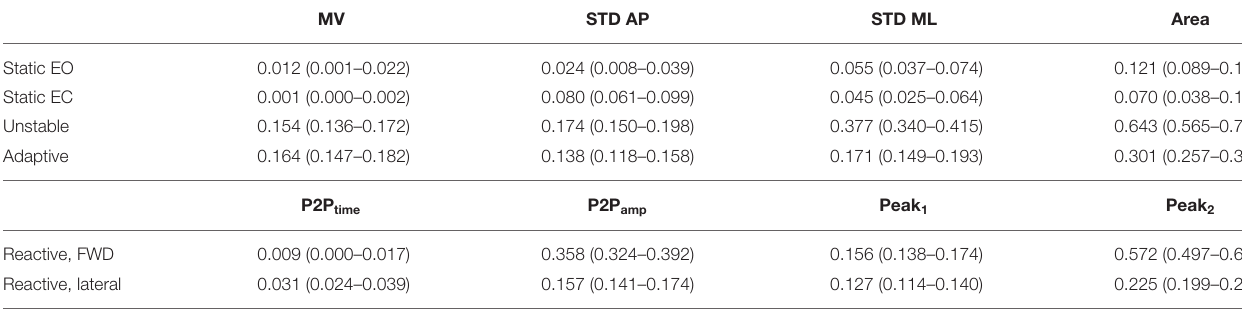
TABLE 1 | a i -value , reported with its confidence interval (with 95% confidence